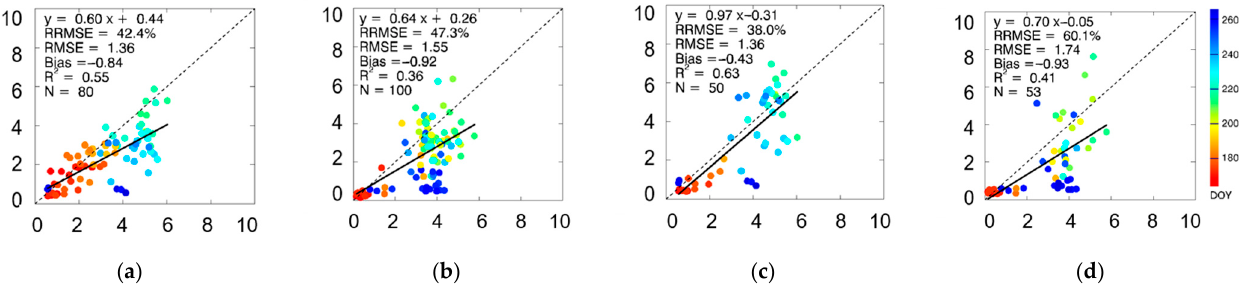
Figure 6. Comparison of the estimated LAI values to the field-measured data for the MODIS BRDF parameters of different qualities: ( a , b ) refer to the results for the wide search method based on BRDF data retrieved by the main algorithm (QA = 0/1) and backup algorithm (QA = 2/3), respectively, and the total number of data points is 180; ( c , d ) are similar to ( a , b ) but for the local search method, and the total number of data points is 103.